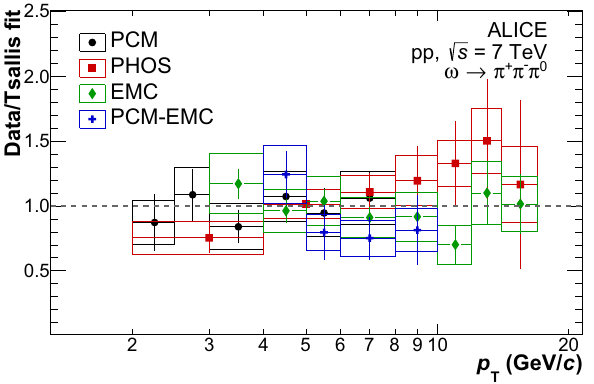
Fig. 4 Ratios of the fully corrected ω spectra obtained with the indi- vidual reconstruction methods to the Levy–Tsallis fit of the combined spectrum, where the fit parameters are shown in Table 2. The statistical and systematic uncertainties are represented by vertical bars and boxes,